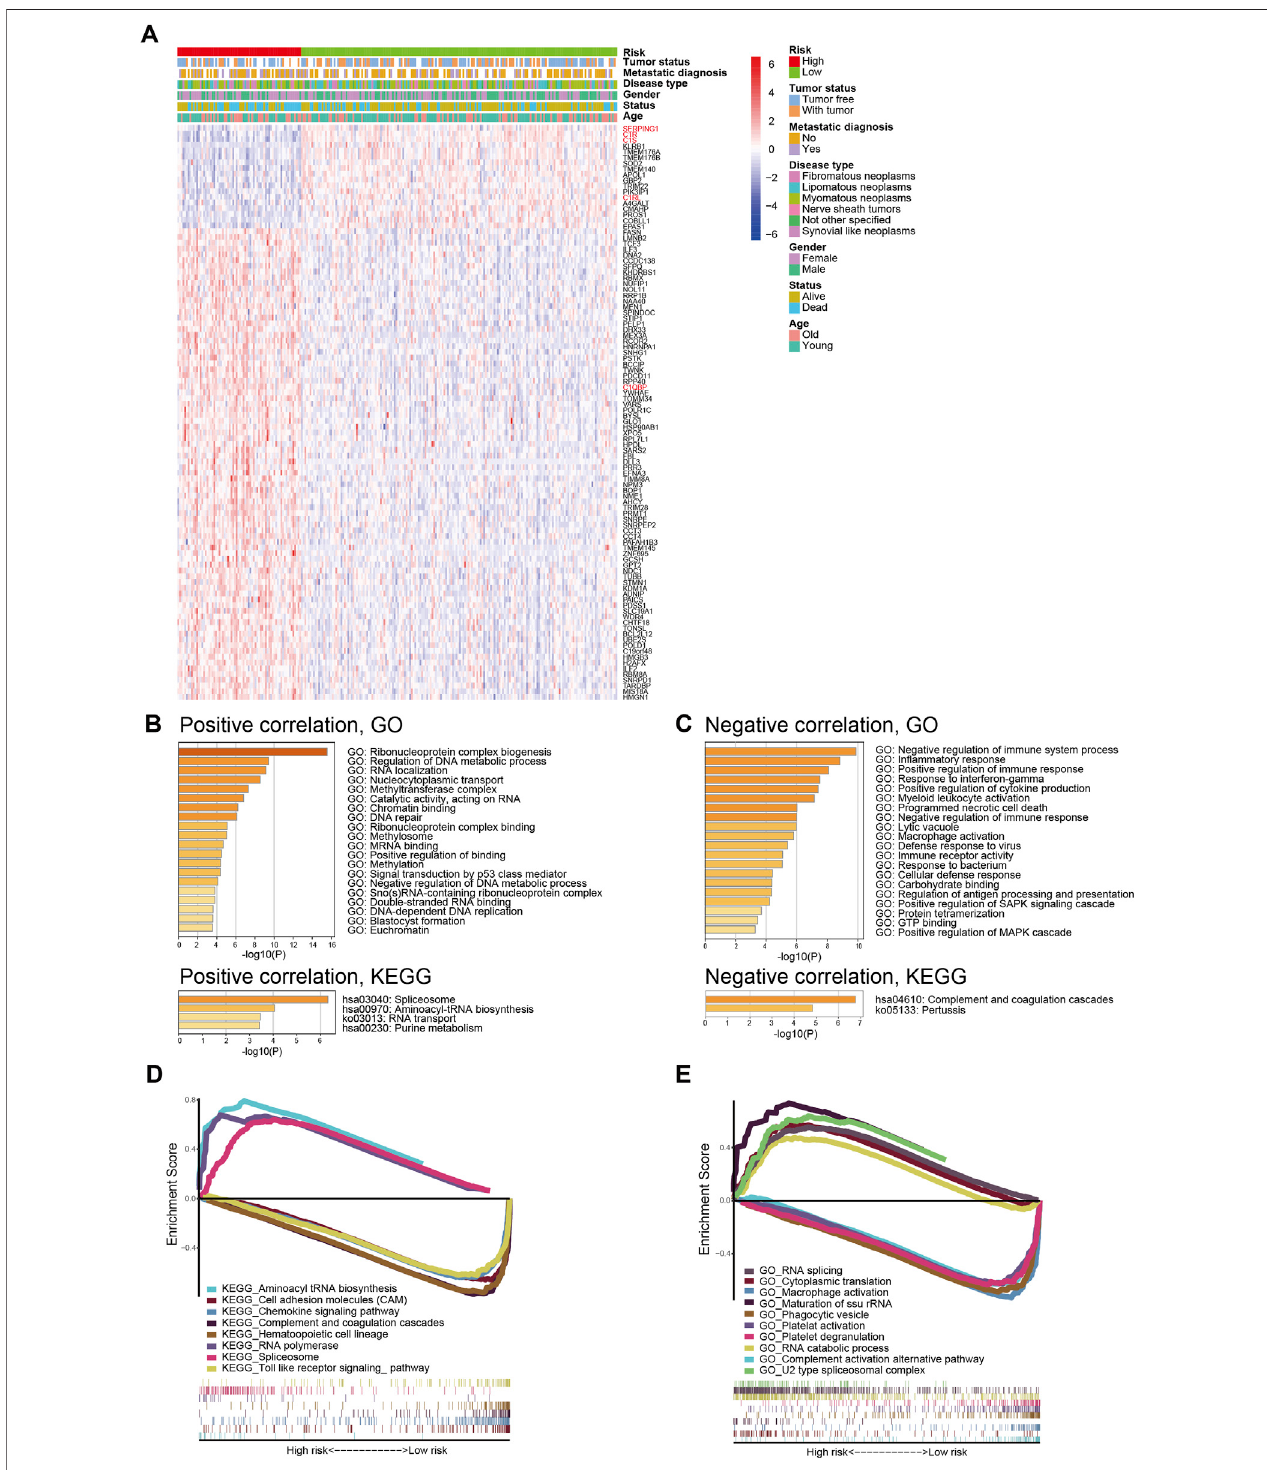
FIGURE 4 | Biological features and pathway analyses of the complement-related gene signature. (A) The relationship between risk, different clinical features, and the top 100 risk score-related genes; red names indicate genes involved in complement classical pathway. (B) GO and KEGG analyses of genes positively correlated withriskscore. (C) GOandKEGGanalysesofgenesnegativelycorrelatedwithriskscore.GSEAofGOterms (D) andKEGGpathways (E) correlatedwithriskscore.GO, Gene Ontology; KEGG, Kyoto Encyclopedia of Genes and Genomes; GSEA, Gene Set Enrichment Analysis.